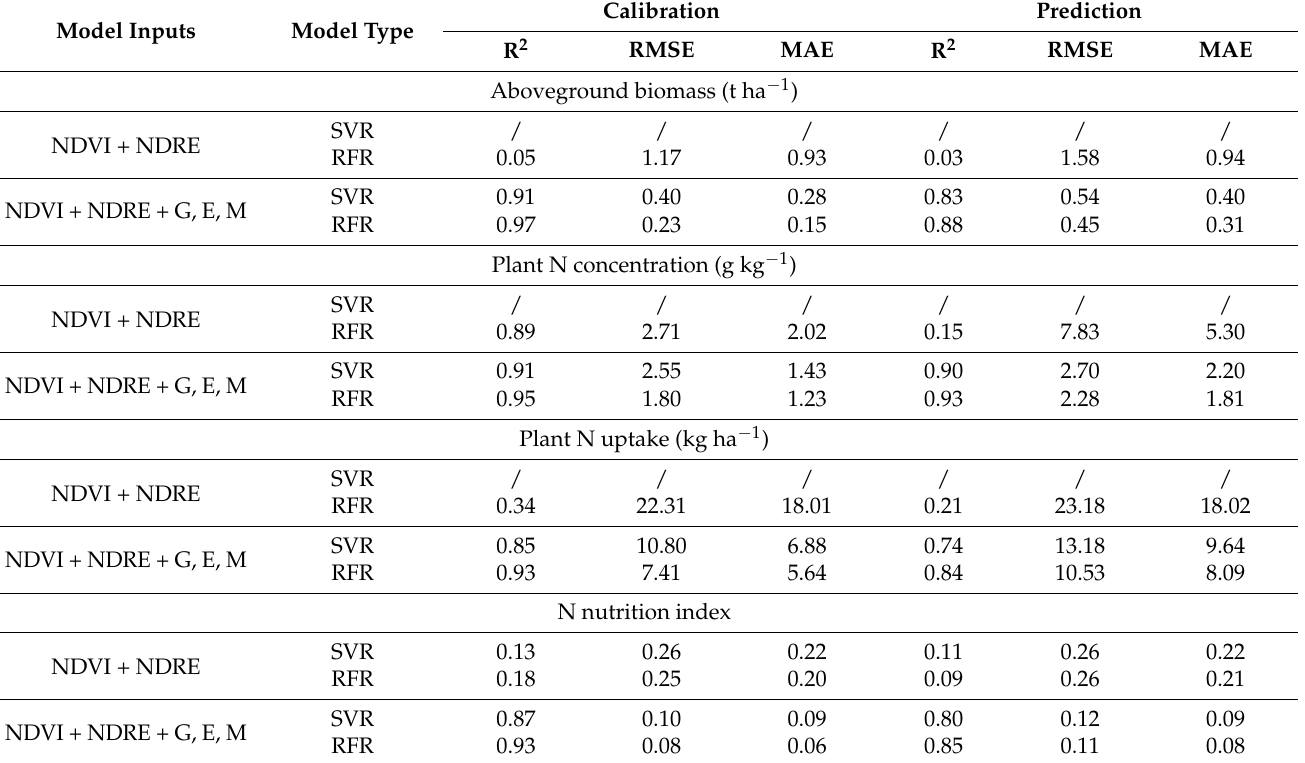
Table 7. The calibration and prediction results of support vector regression (SVR) and random forest regression (RFR) models using different input variables for predicting corn aboveground biomass, plant N concentration, plant N uptake, and N nutrition index across site-years at around the V9 growth stage. Here, G, E, and M refer to genetic, environmental, and management information,